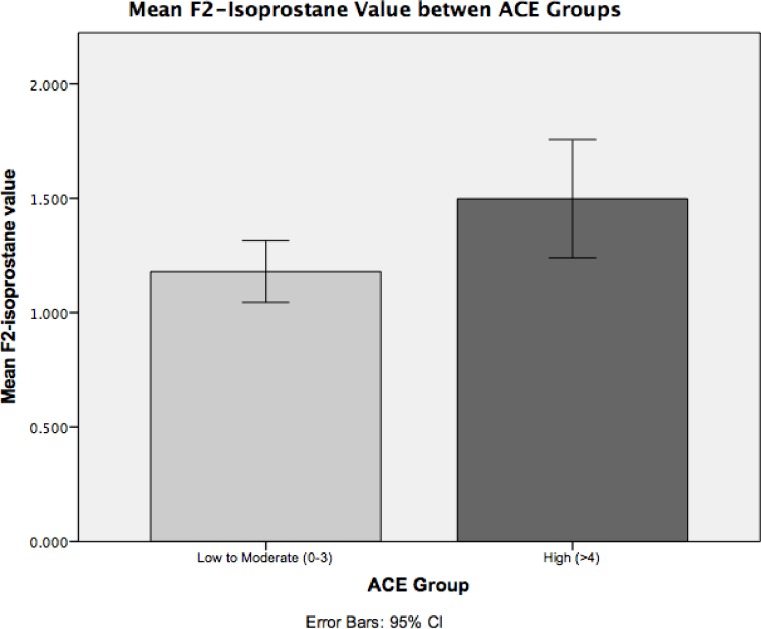
Mean F2-Isoprostane Value in Low to Moderate v High ACE Groups.